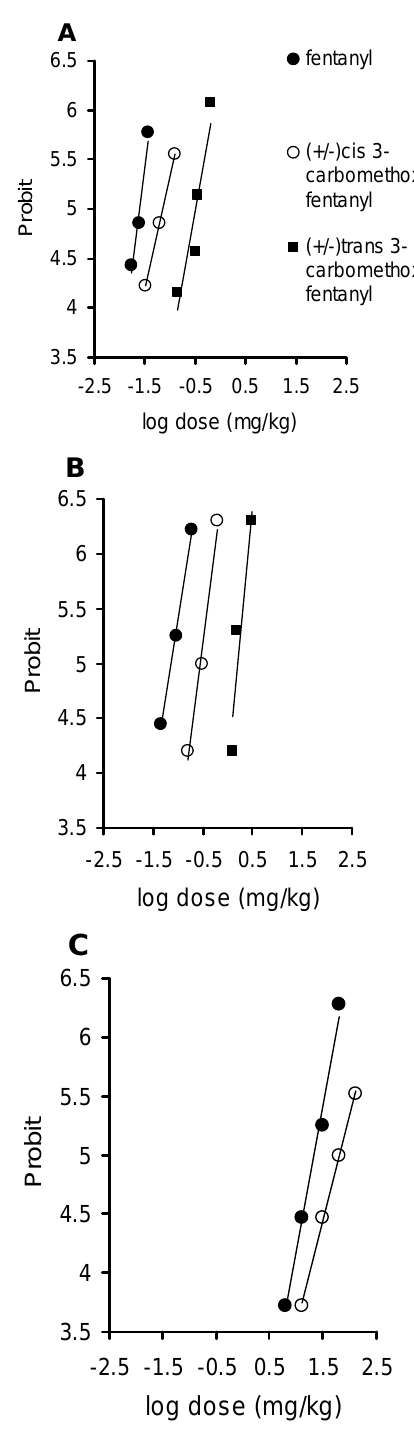
Figure 2. Log dose-probit curves for antinociception (hot plate) (A), motor impairment (rotarod test) (B) and lethality (C) for fentanyl, (±) cis -3-carbomethoxyfentanyl and (±) trans- 3-carbomethoxyfentanyl, in mice, after i.p. drug administration. For antinociception, the following criterion was used: an antinociceptive effect was said to have occurred if postdrug response latency was doubled in respect to the control predrug latencies. Motor impairment was detected in the animal unable to maintain equilibrium on the rotating rod for 60 s. Each point represents the probit value obtained from at least 6